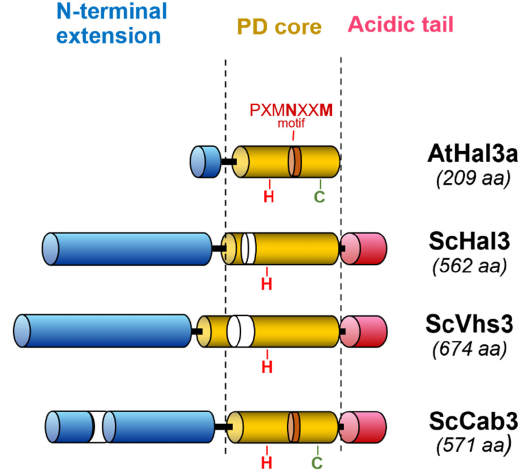
Figure 1. Comparison of overall A. thaliana AtHal3a with the S. cerevisiae Hal3, Vhs3 and Cab3 proteins. The core PPCDC domains are shown in gold, the N-terminal extensions in blue and the C-terminal acidic tails in red. Sequence insertions specific to the protein is denoted by uncolored segments. The location of the catalytic residues described in the text is shown.